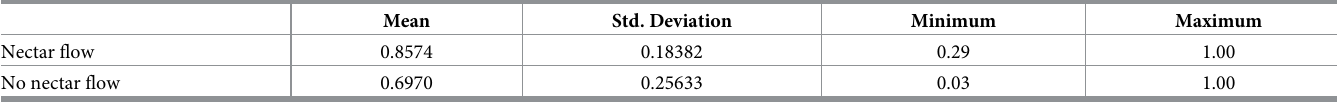
Table 4. Descriptive statistics of 32 colonies tested twice for hygienic behaviour: Once during a nectar flow and once without a nectar